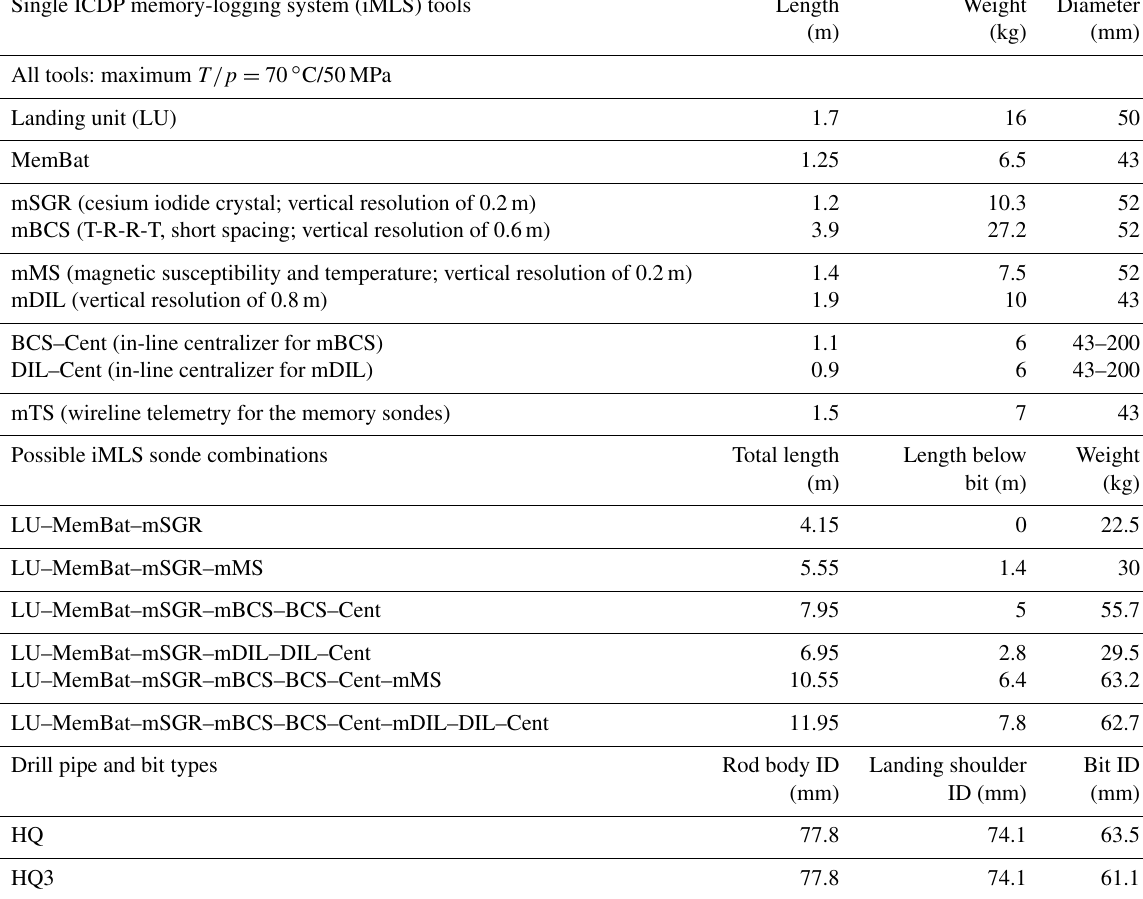
Table 1. Technical specifications. mSGR refers to the spectrum of the natural gamma radiation – total GR, K, U, and Th; mBCS refers to borehole-compensated sonic velocity – full waveforms, Vp and Vs; mMS refers to the magnetic susceptibility and temperature; and mDIL refers to electric resistivity and induction – Rmedium and